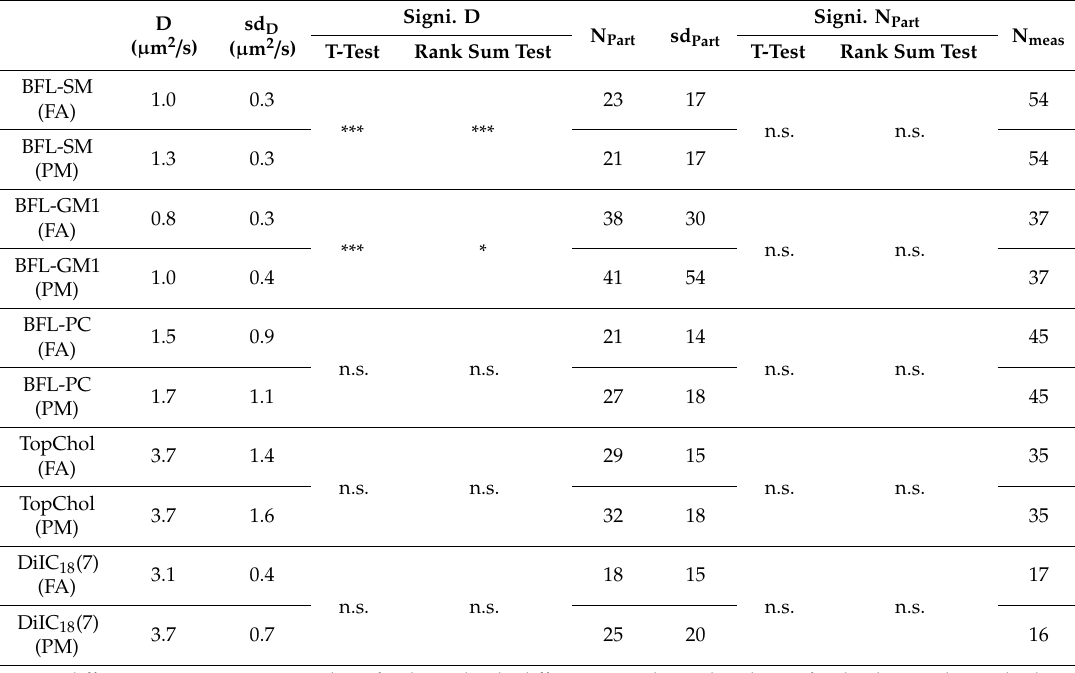
Table 1. Characteristic di ff usion parameters of di ff erent fluorescent membrane tracers determined by FCS inside (FA) and outside (PM) of FAs of cardiac myofibroblasts. Signi. D sd D ( µ m 2 / s) ( µ m 2 / s)